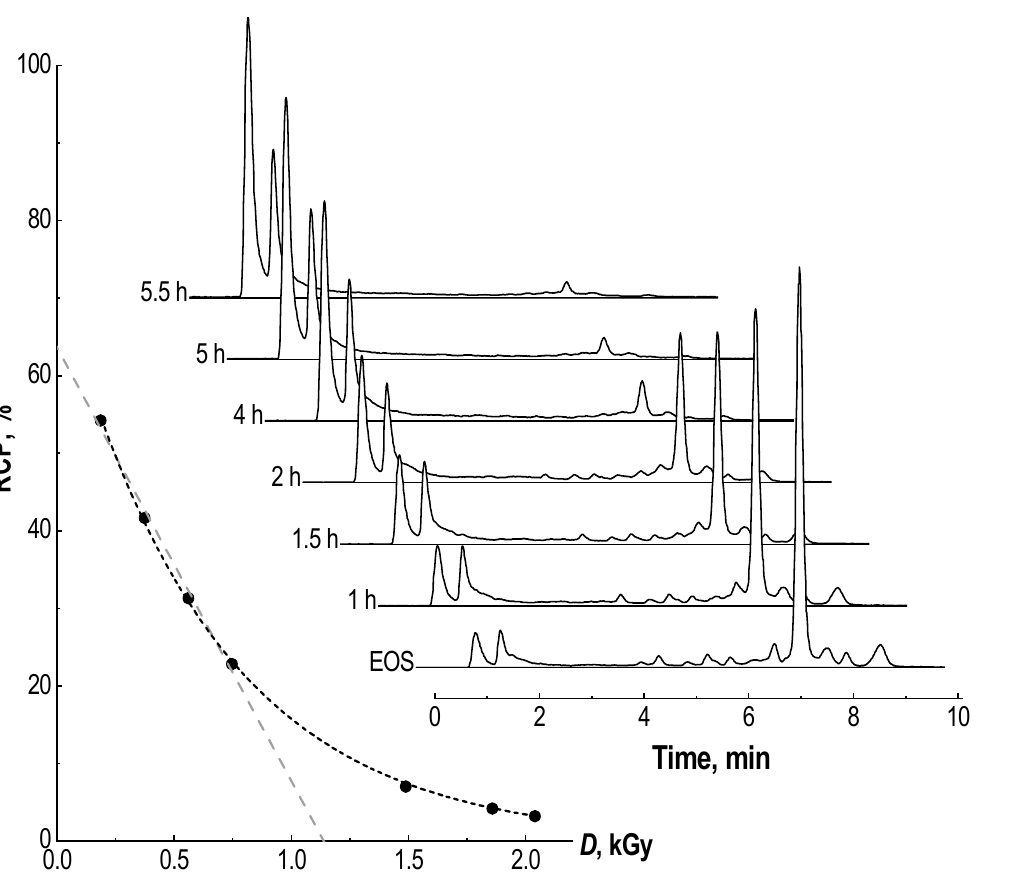
Figure 4. Dependence of [ 177 Lu]Lu-PSMA-617 radiochemical purity on the absorbed dose (kGy) accumulated during storage ( left ) and corresponding radio-HPLC chromatograms ( right ): sample volume—1 mL, 177 Lu activity in the sample—4.8 GBq, 100 μ g of PSMA-617, pH 4.5, C(Na-acetate) = 0.03 mol/L, synthesis at 95 °C for 30 min (black dashed line here represents exponential approximation of the experimental data Y = 73·exp( − X/653), R 2 = 0.9996; linear regression for the first four data points (gray dashed line)—Y = 64 − 0.056·X, R 2 = 0.9962); for corresponding radio-TLC chromatograms see Supplementary Materials Figure S4.